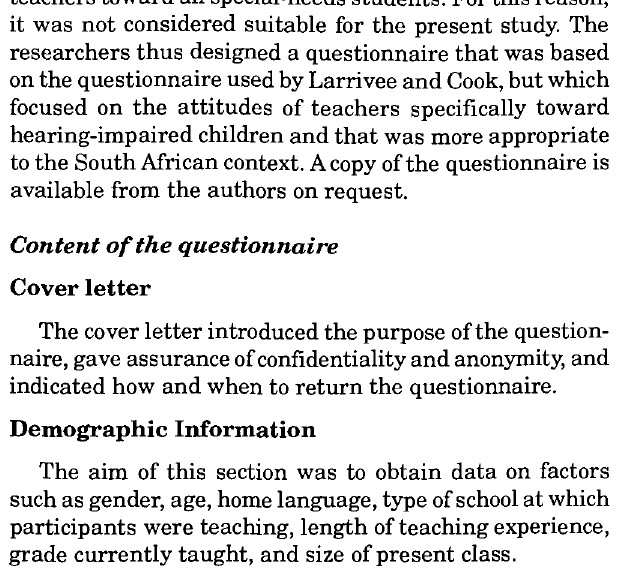
TABLE 1: Description of Subjects (N=90) Demographic